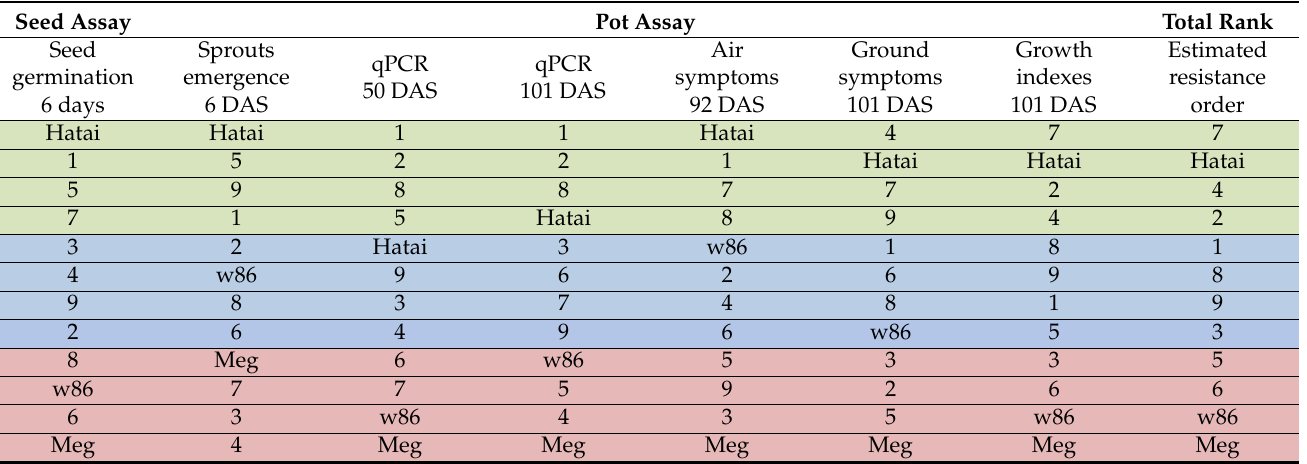
Table 3. Evaluation of the maize cultivars’ resistance order based on the various tests conducted in this work a . Pot